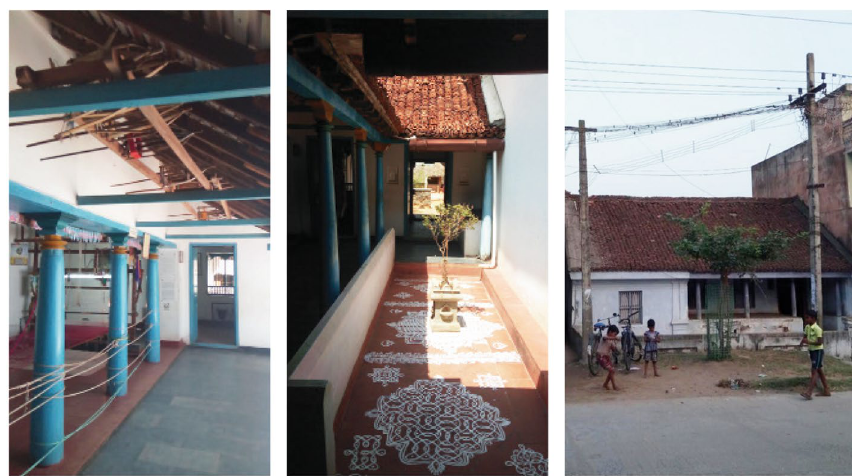
Fig. 15 Photographs depicting the roof structure, courtyard and thinnai of the traditional single-family dwelling (Source: the author)